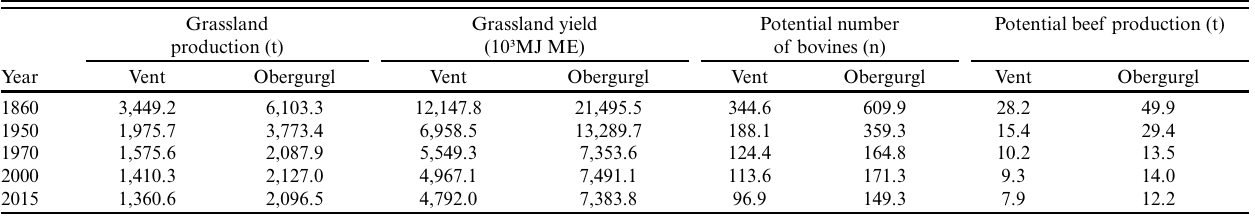
Table 2 . Development of the permanent grassland production, the grassland energy yield, the resulting fodder potential for bovines, and the produced beef as ecosystem services (ES) flows for the villages of Vent and Obergurgl. Grassland Grassland yield Potential number Potential beef production production (t) (10³MJ ME) of bovines (n)